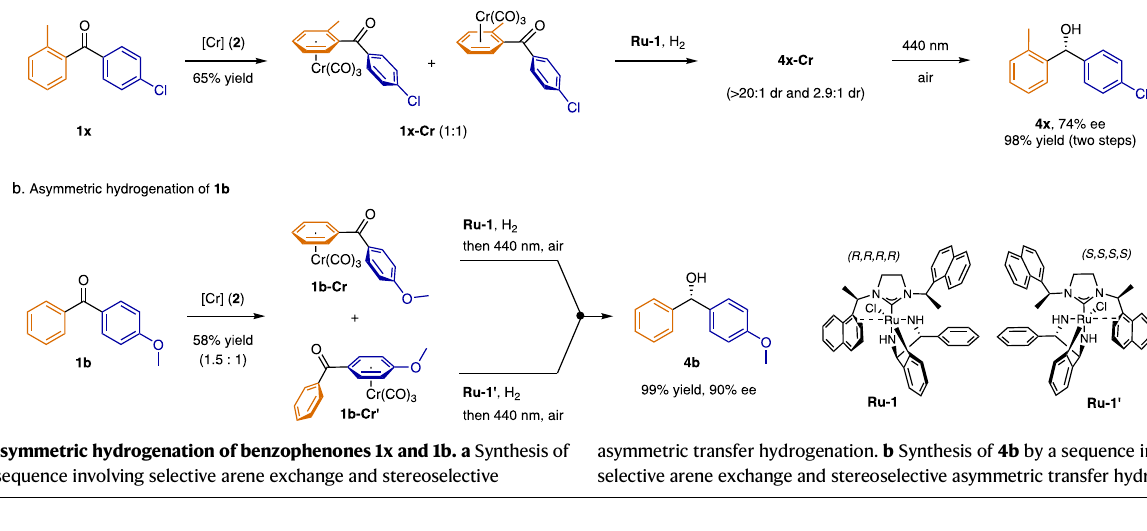
Fig. 5 | Asymmetric hydrogenation of benzophenones 1x and 1b. a Synthesis of 4x by a sequence involving selective arene exchange and stereoselective